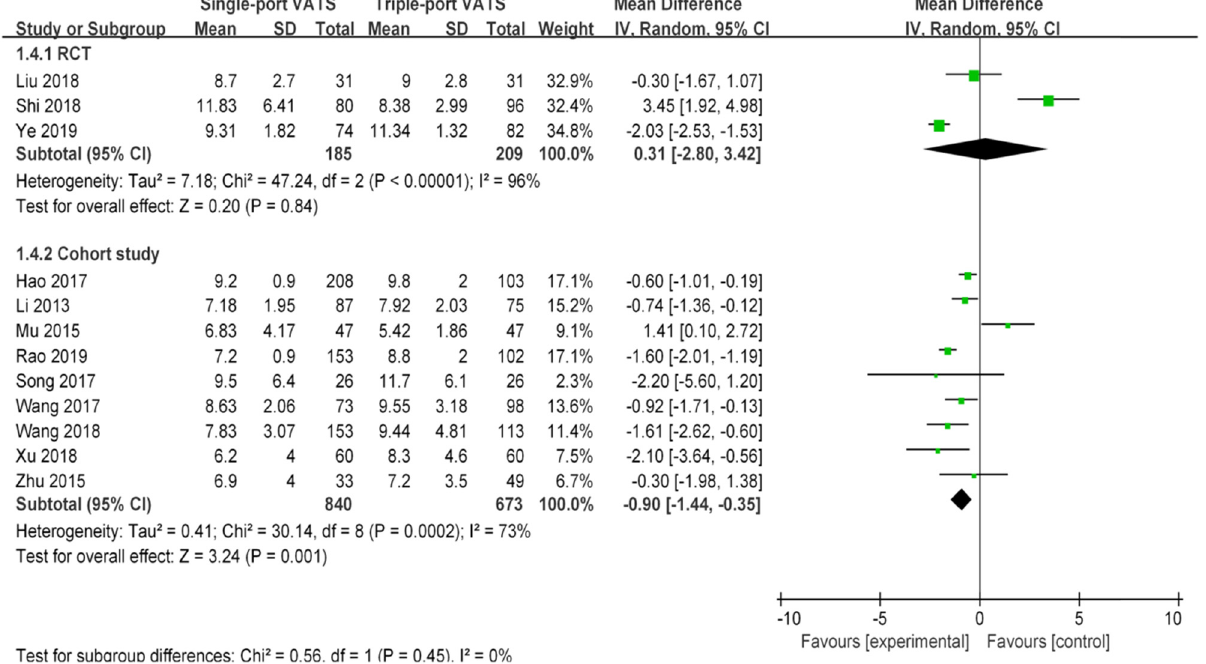
Figure 5: Forest plots of postoperative hospital stays for single - and triple - VATS lobectomy. For each study, the estimated OR ( shown as square ) and its 95% CI ( shown as horizontal line ) were plotted. The pooled OR and 95% CI were plotted as black